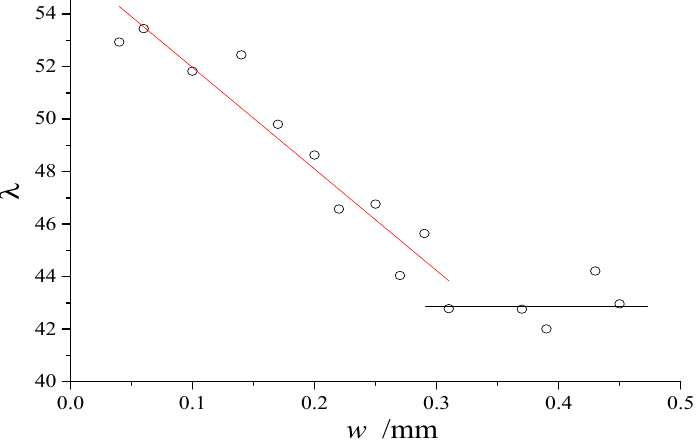
Figure 9. The relationship between λ and crack width by statistics.